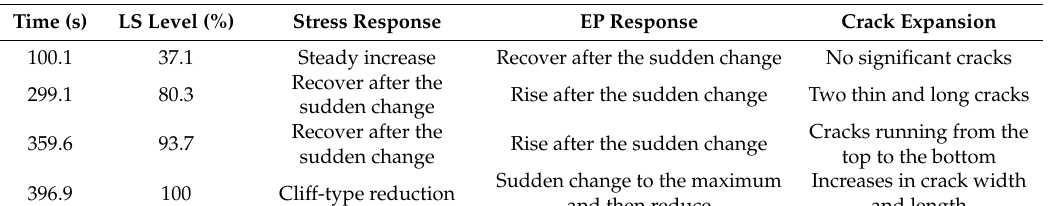
Table 2. Statistics on characteristics of EP, AE and crack expansion under different loading time